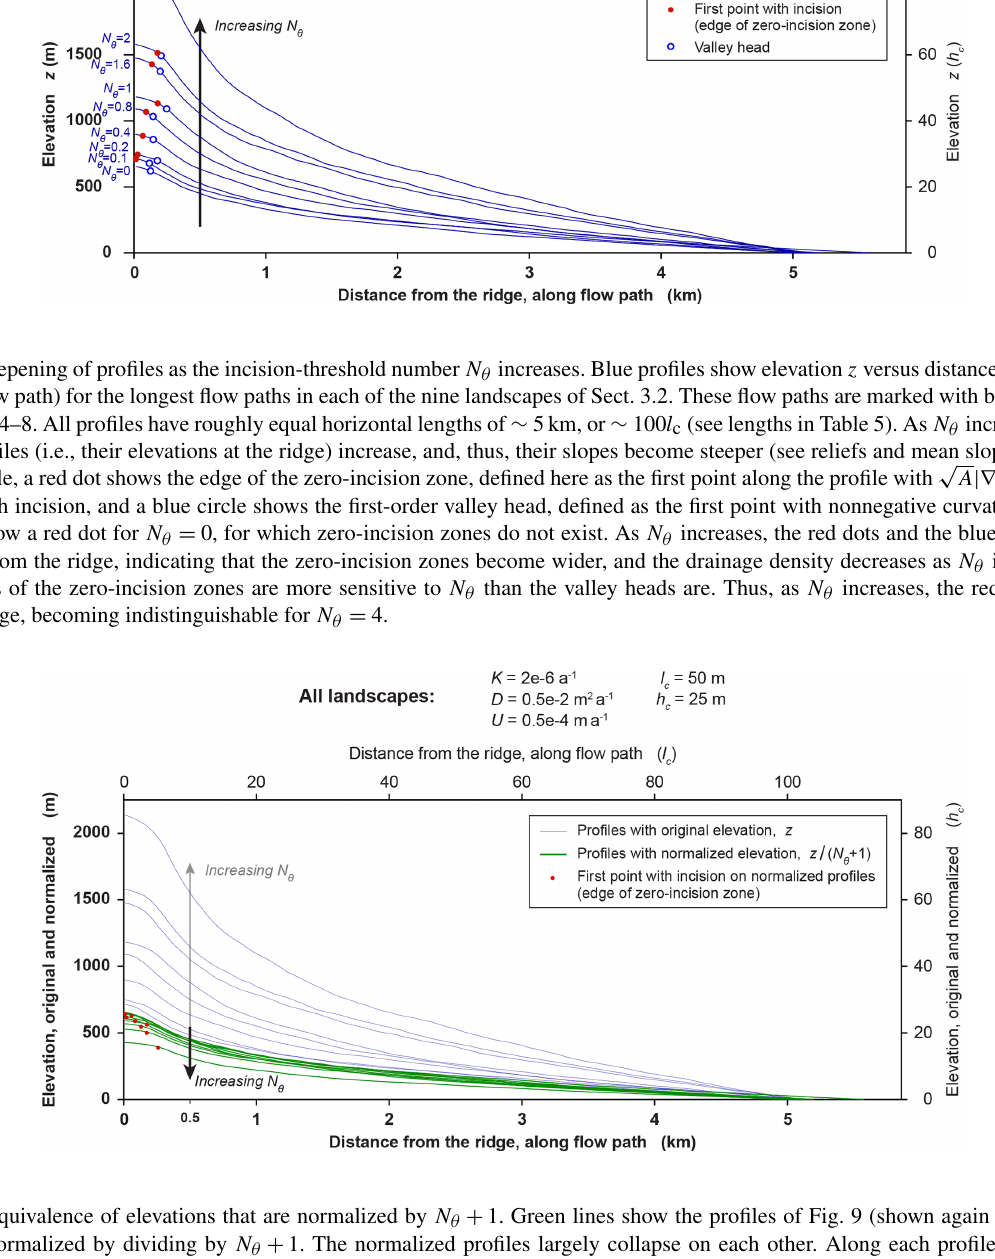
Figure 10. Equivalence of elevations that are normalized by N θ + 1. Green lines show the profiles of Fig. 9 (shown again here with light blue lines), normalized by dividing by N θ + 1. The normalized profiles largely collapse on each other. Along each profile, this tendency becomes stronger in the downstream direction, where the distance from the zone of zero incision grows (the edges of zero-incision zones are indicated by red dots). As N θ increases, the normalized profile elevations generally decrease slightly, whereas the original profile elevations increase substantially (see Table 5, which gives elevations, original and normalized, at a distance of 0.5km from the ridge, which is roughly the location of the black arrow in this